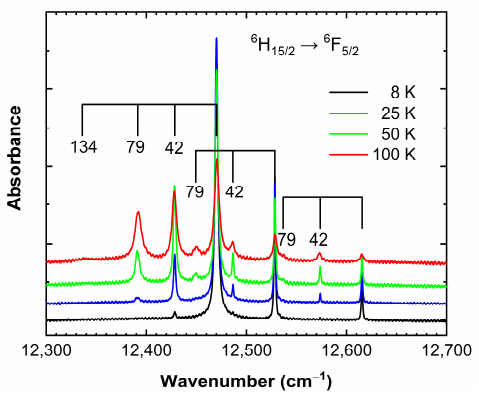
Figure 4. Temperature dependence of the 6 H 15/2 → 6 F 5/2 transition of Dy 3+ ions in the LYB:Dy(1 mol%) crystal. The hot bands show that the lowest energy crystal field components of the ground state are found at 42, 79 and 134 cm −1 .